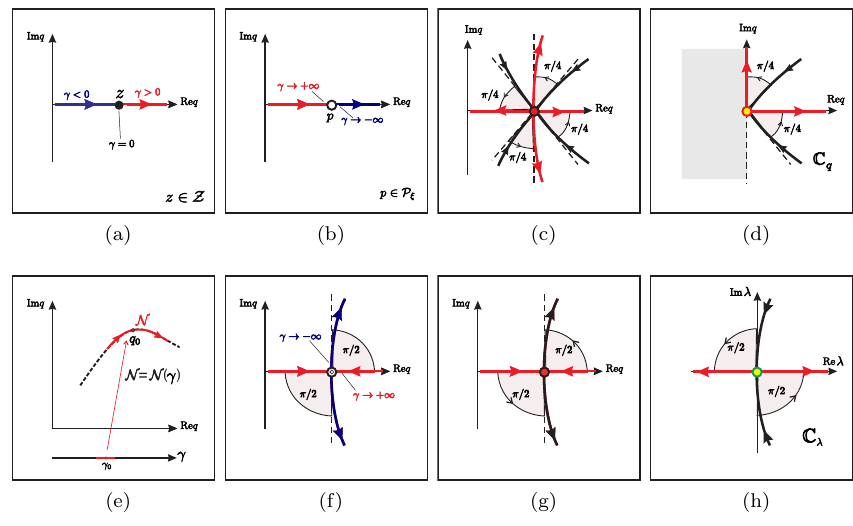
Figure 5. Spectrum Curves. – Pole Point of the second order, – Branch